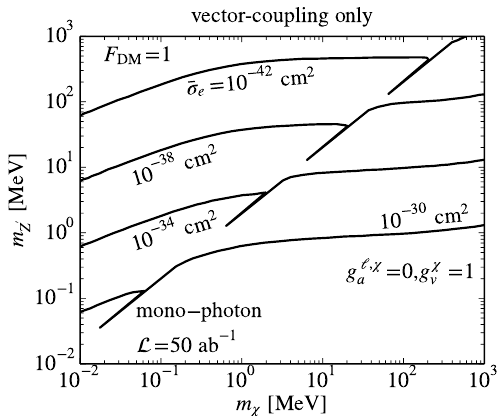
Figure 4 . The expected Belle II upper bound on ¯ σ e for each model point in the m χ − m Z 0 plane, in the mono-photon channel with 50 ab − 1 , where only vector couplings are considered. We have estimated the limits in the vicinity of m = 2 m , where the Belle II sensitivity is highly enhanced. Z 0 χ The limits along the m = 2 m line are shown for illustrative purposes only; the more accurate Z 0 χ values require a detailed analysis which is beyond the scope of the current